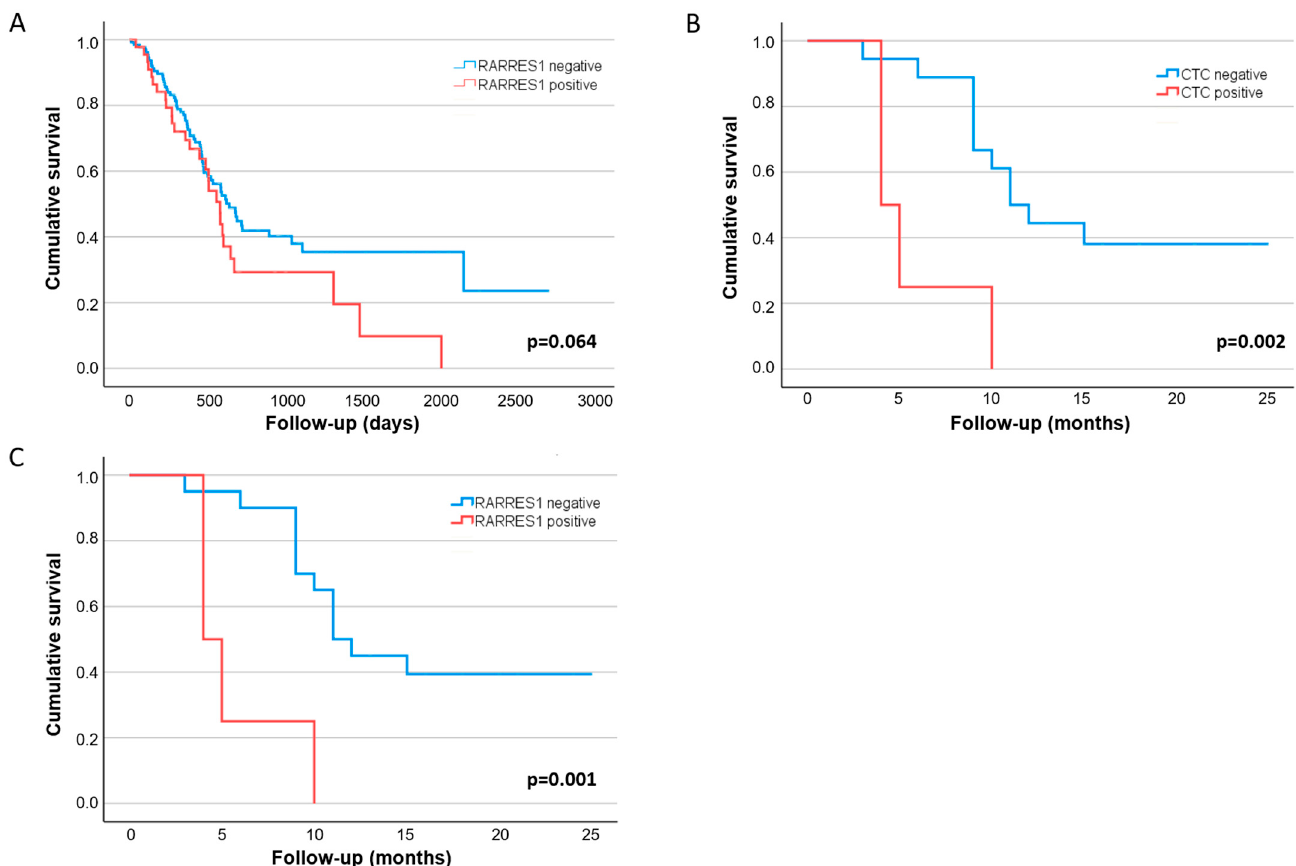
Figure 2. RARRES negative and positive CTCs, with cytokeratine, DAPI, and RARRES1 staining . CTCs detected via immunofluorescence staining. The upper panel shows tow CTCs with no protein expression of RARRES1, whereas the lower panel shows a single RARRES1 positive CTC.